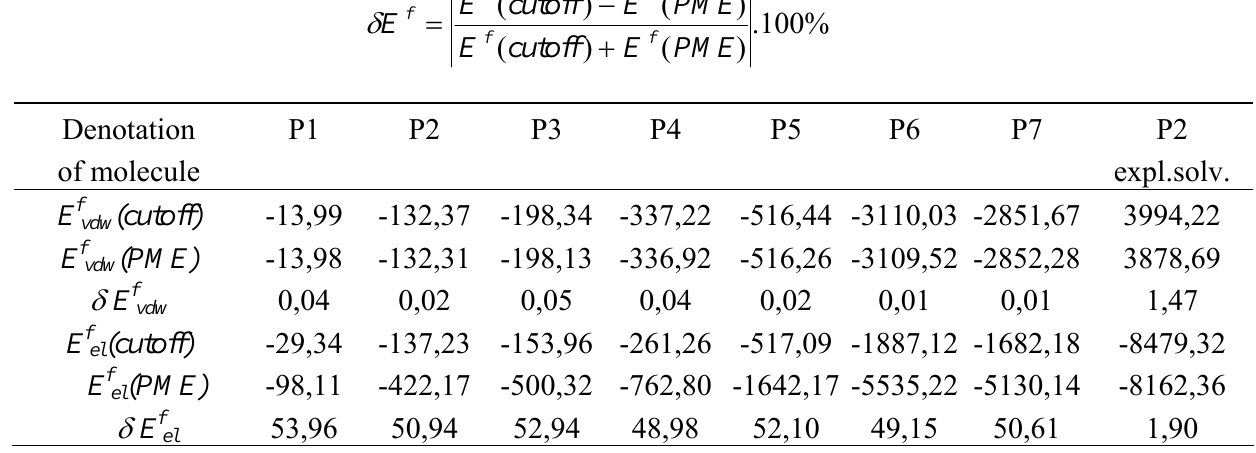
Figure 5. Dependency of electrostatic energy (calculated using cutoff method) on cutoff for implicit solvent (default value for dielectric multiplicative constant of 1.0) and explicit solvent (without including solvent-solvent interactions) for peptide P2. Table 6. Final energies (kcal/mol) calculated using cutoff E f (cutoff) and PME E f (PME) methods. The relative difference of absolute energies δ E f (%) was calculated using